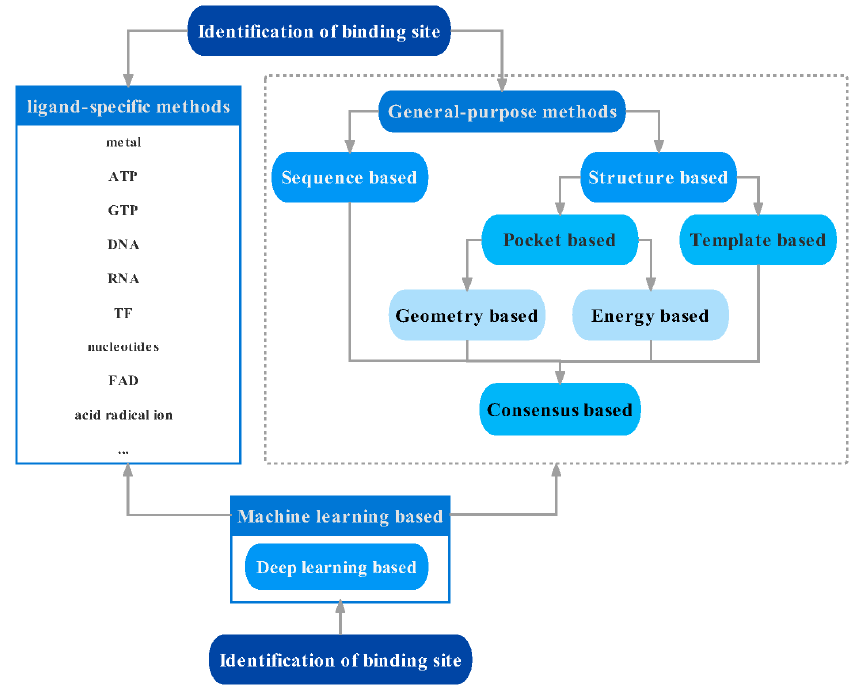
Figure 3. Classification of methods for the identification of binding sites.